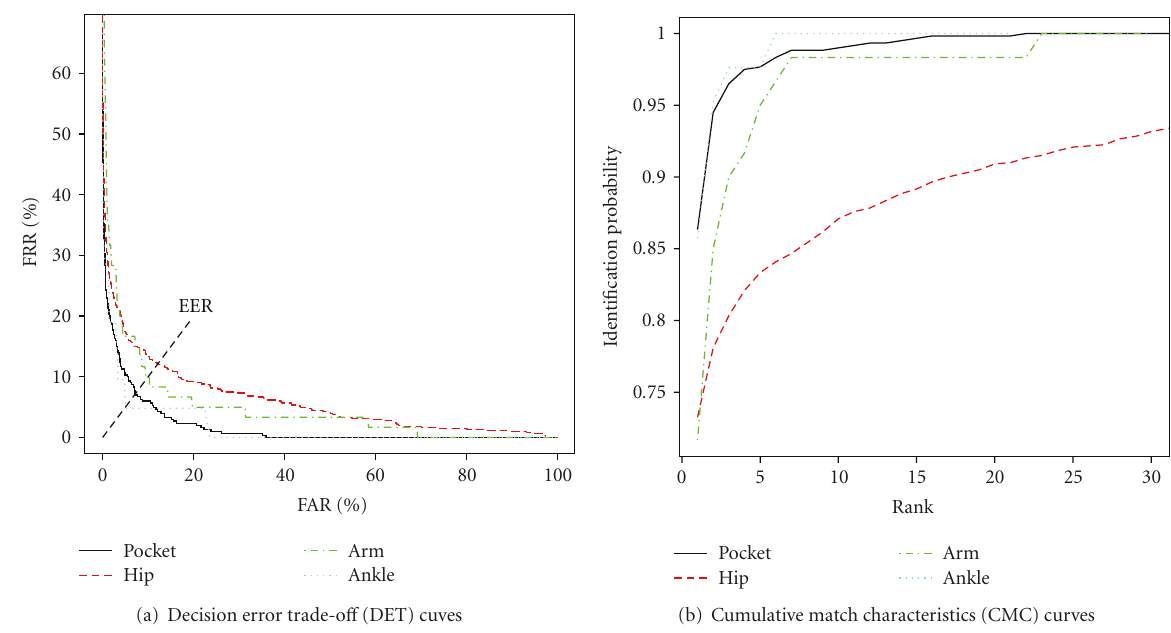
Figure 6: Performances in terms of DET and CMC